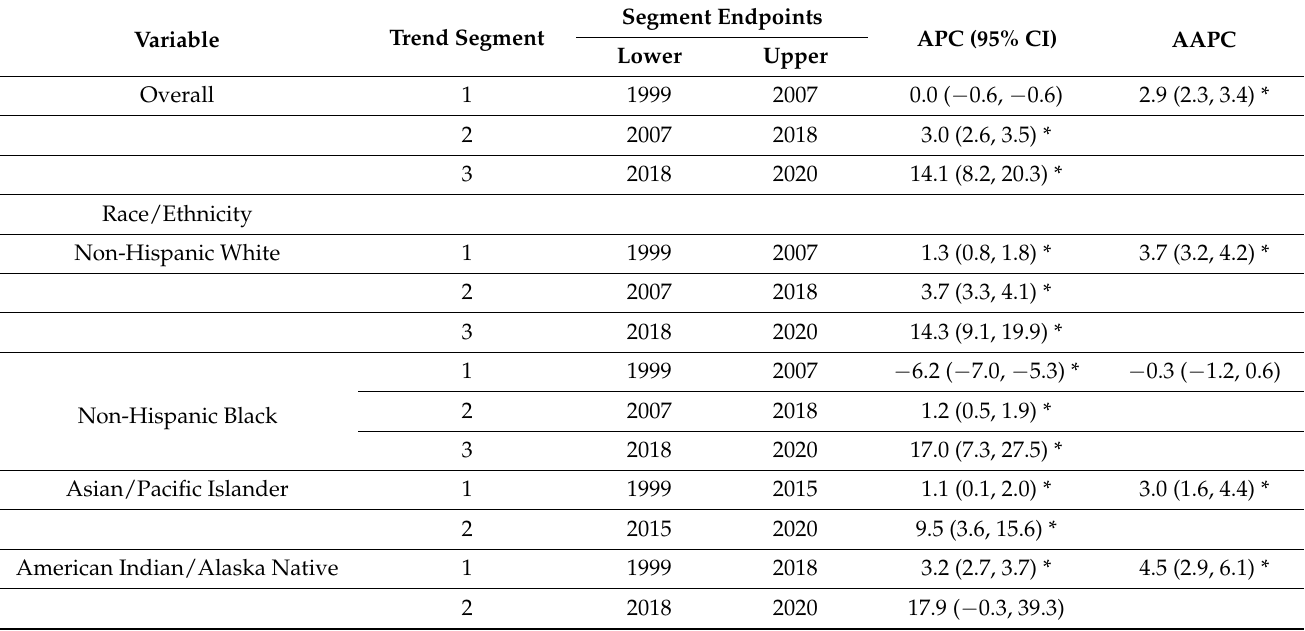
Table 2. Annual Percentage Changes (APC) and Average Annual Percentage Changes (AAPC) in Alcohol-Induced Mortality in the US, United States,